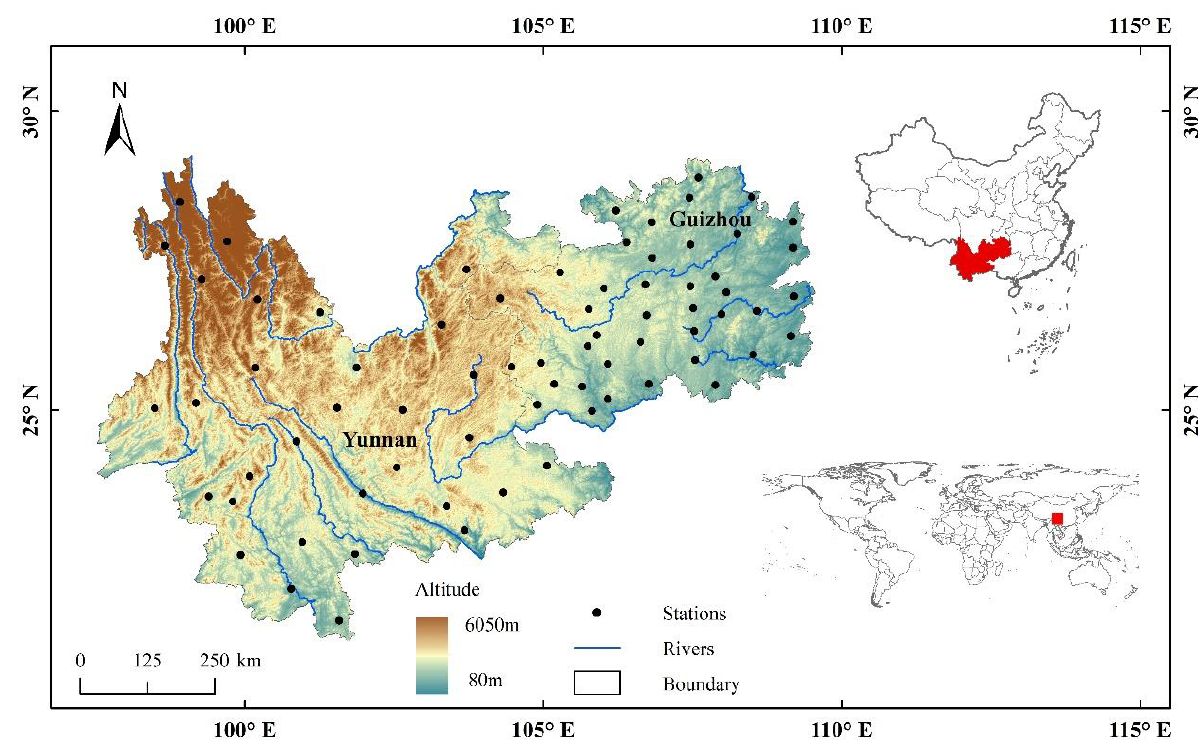
Figure 1. Location map of Yunnan – Guizhou Plateau and meteorological stations.